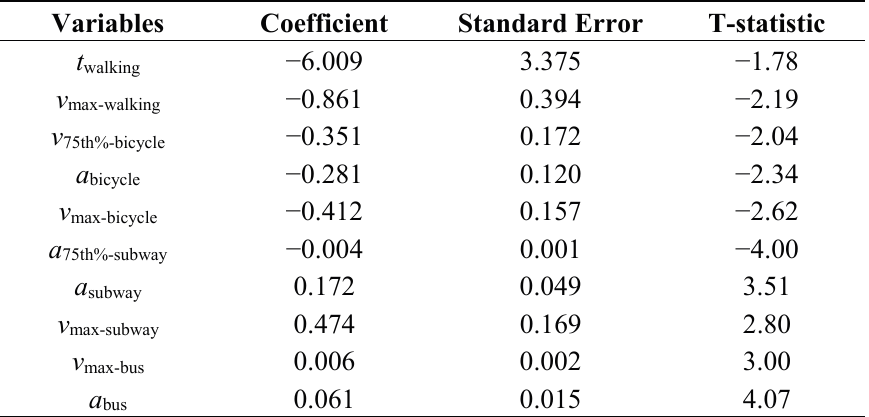
Table 7. Estimation results of the mode detection model.